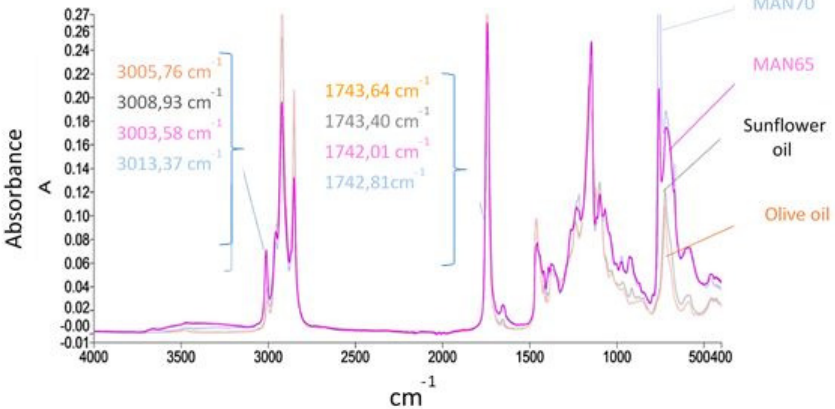
Figure 5. Comparison of Fourier transform infrared spectra of thraustochytrid oils (MAN65 and MAN70) with sunflower and olive oils.